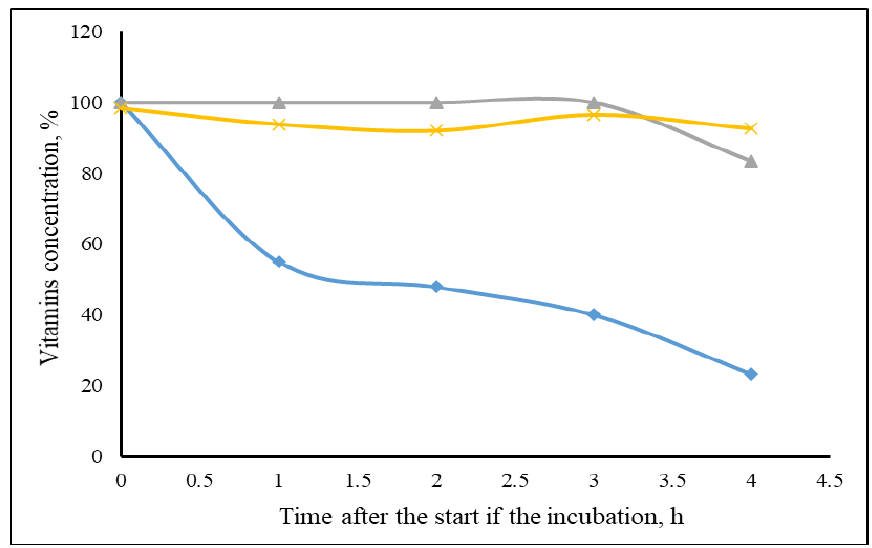
Figure 1. Recovery rate of vitamin A ( ♦ ), vitamin D ( ▲ ) and vitamin E (×) in in vitro gastro intestinal digestion method. Table 1. Adsorption index of the six mycotoxin binders with vitamins D and E when incubated separately or together.